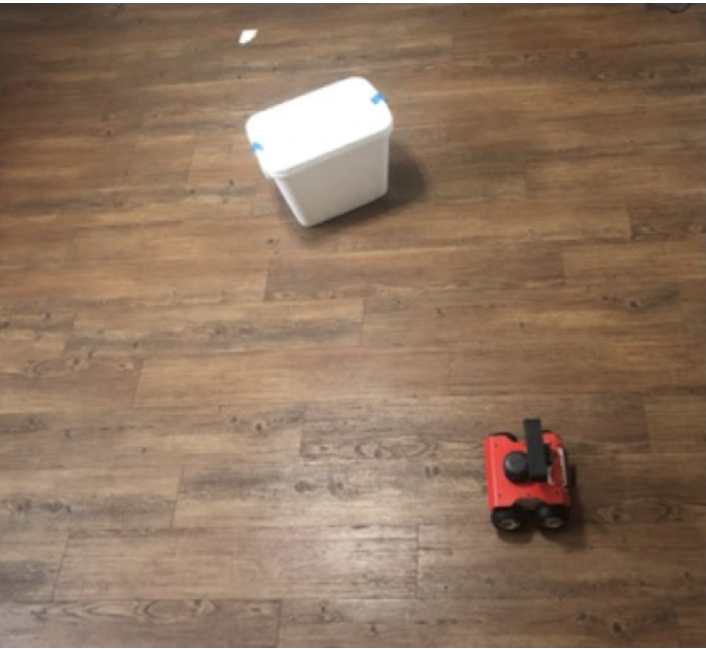
Figure 12. The “Titanic” test